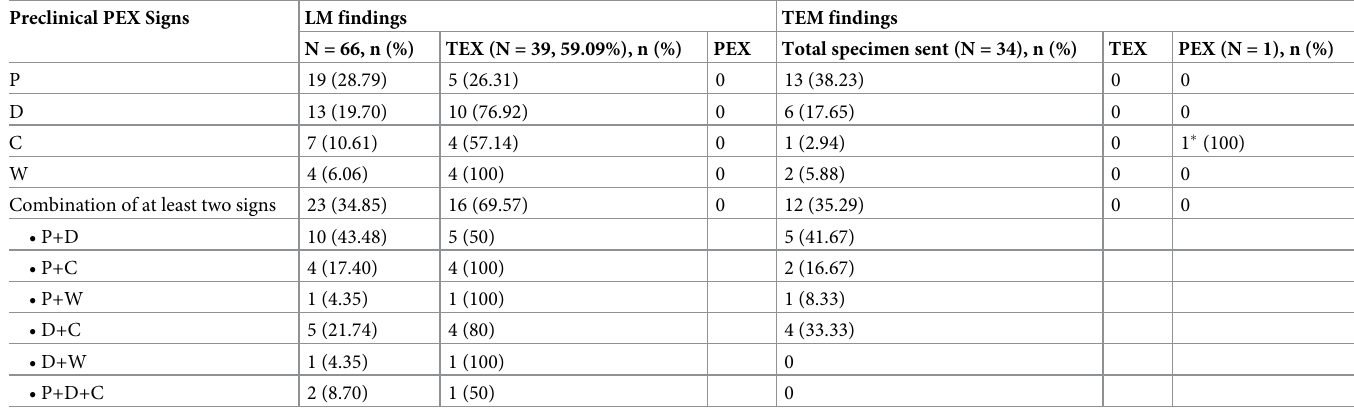
Table 1. Clinical, light, and electron microscopic features of anterior lens capsules in preclinical pseudoexfoliation syndrome. Preclinical PEX